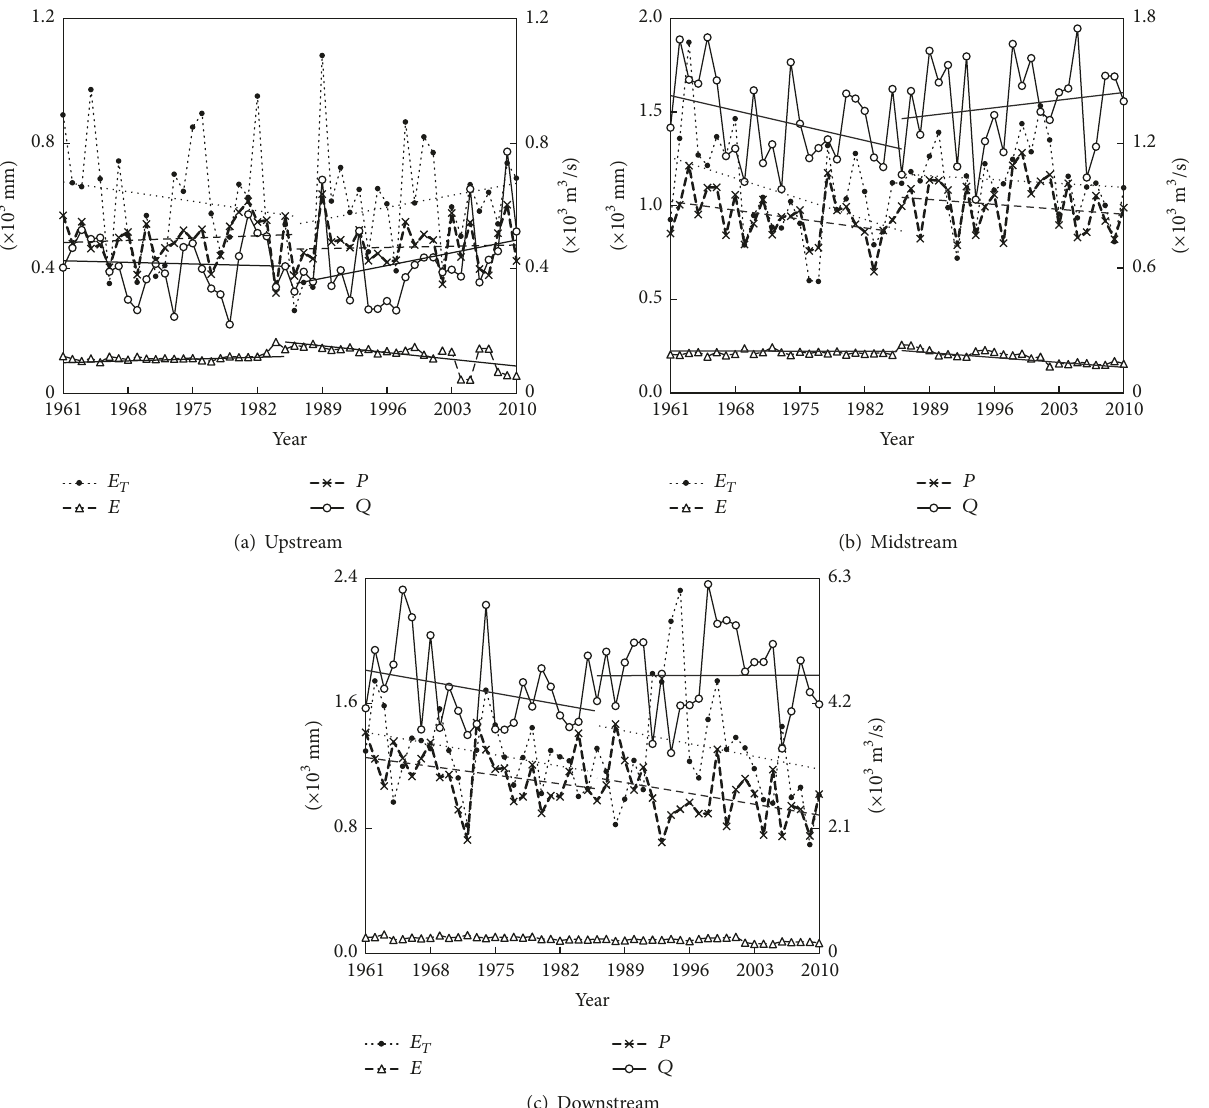
Figure 2: Streamflow, precipitation, potential and actual evapotranspiration, and their trend-lines at upstream, midstream, and downstream. Table 2: Slope in cumulative runoff, precipitation, and evaporation during the baseline period ( 𝐴 ) and change period ( 𝐵 ). Divisions